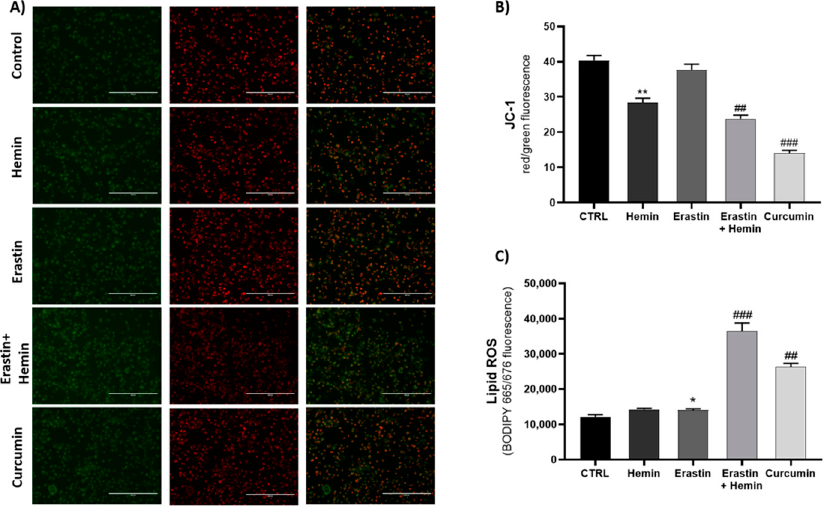
Figure 4. ( A ) Fluorescence images of JC-1 staining after 8 h of treatment. ( B , C ) Evaluation of treatment effects on mitochondrial membrane potential and lipid ROS accumulation (* p < 0.05, ** p < 0.005, vs. CTRL; ## p < 0.005, ### p < 0.0005 vs. erastin). The results are expressed as means ± SEM.